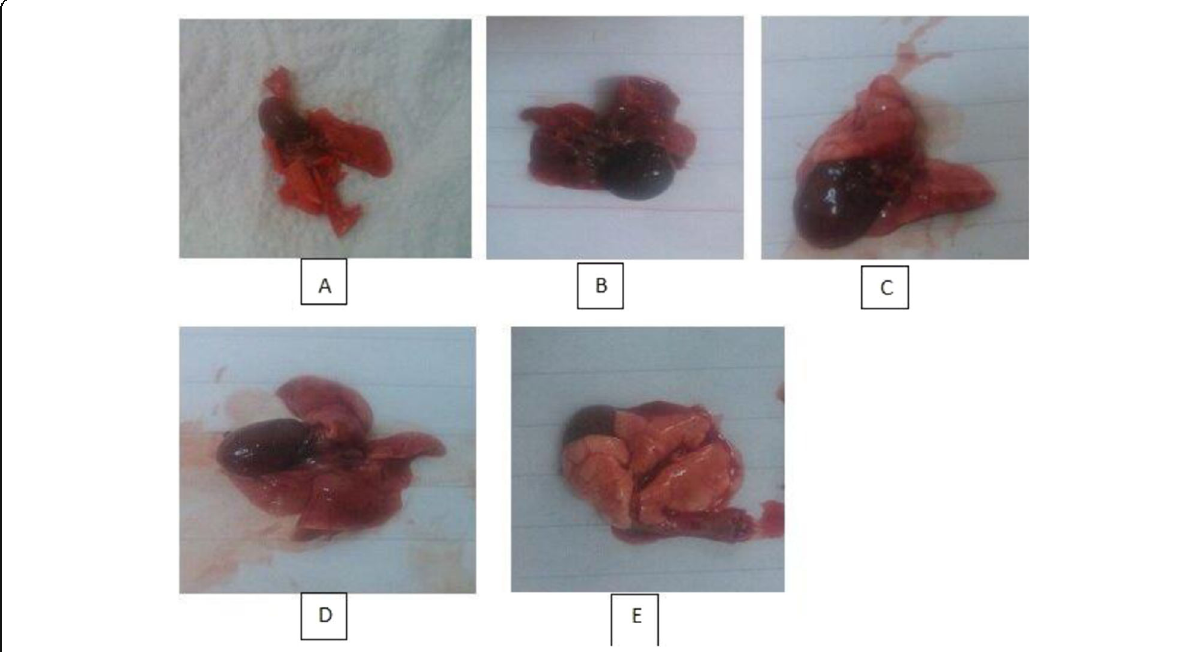
Fig. 8 Photographic lesions in lungs of rat groups: A negative control, B PBS group, C pUCP24 group, D inactivated vaccine, and E DNA